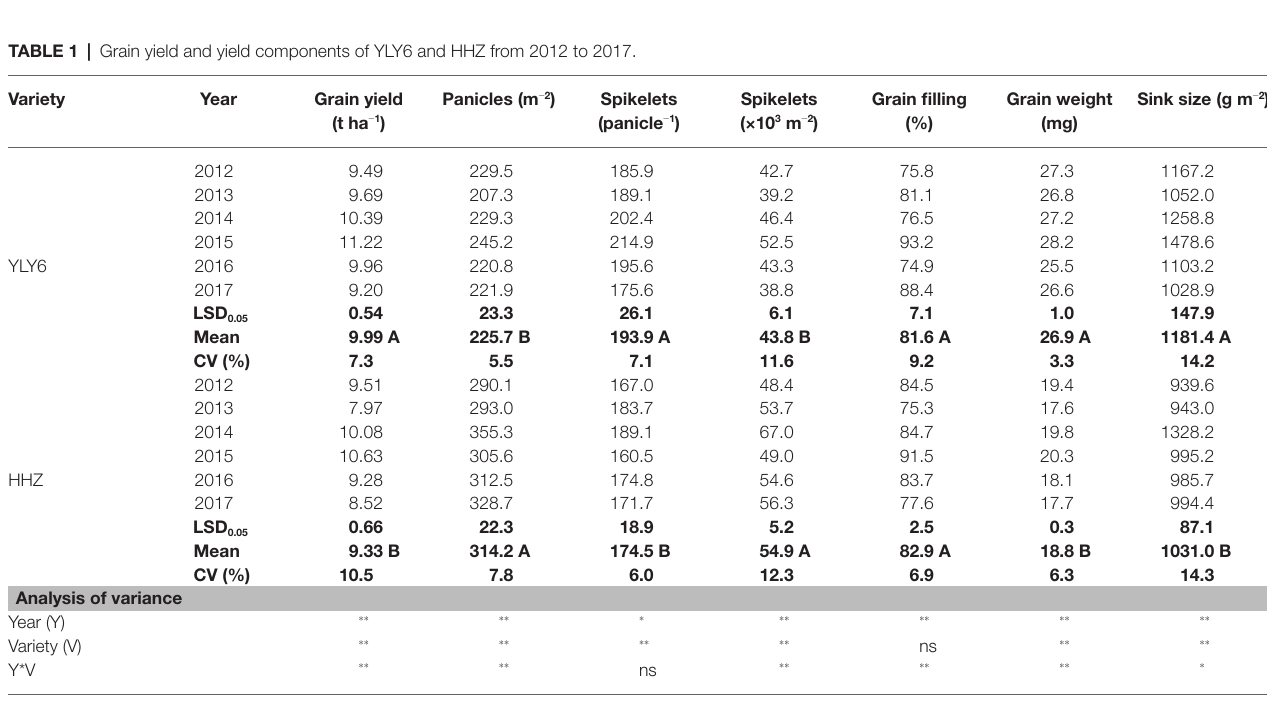
FIGURE 2 | Growth duration of YLY6 (A) and HHZ (B) from seeding to transplanting, transplanting to heading, and heading to maturity in Hubei Province, China, from 2012 to 2017. The numbers above the columns represent total growth duration from seeding to maturity. SD – seeding; TP – transplanting; HD – heading; PM – maturity.